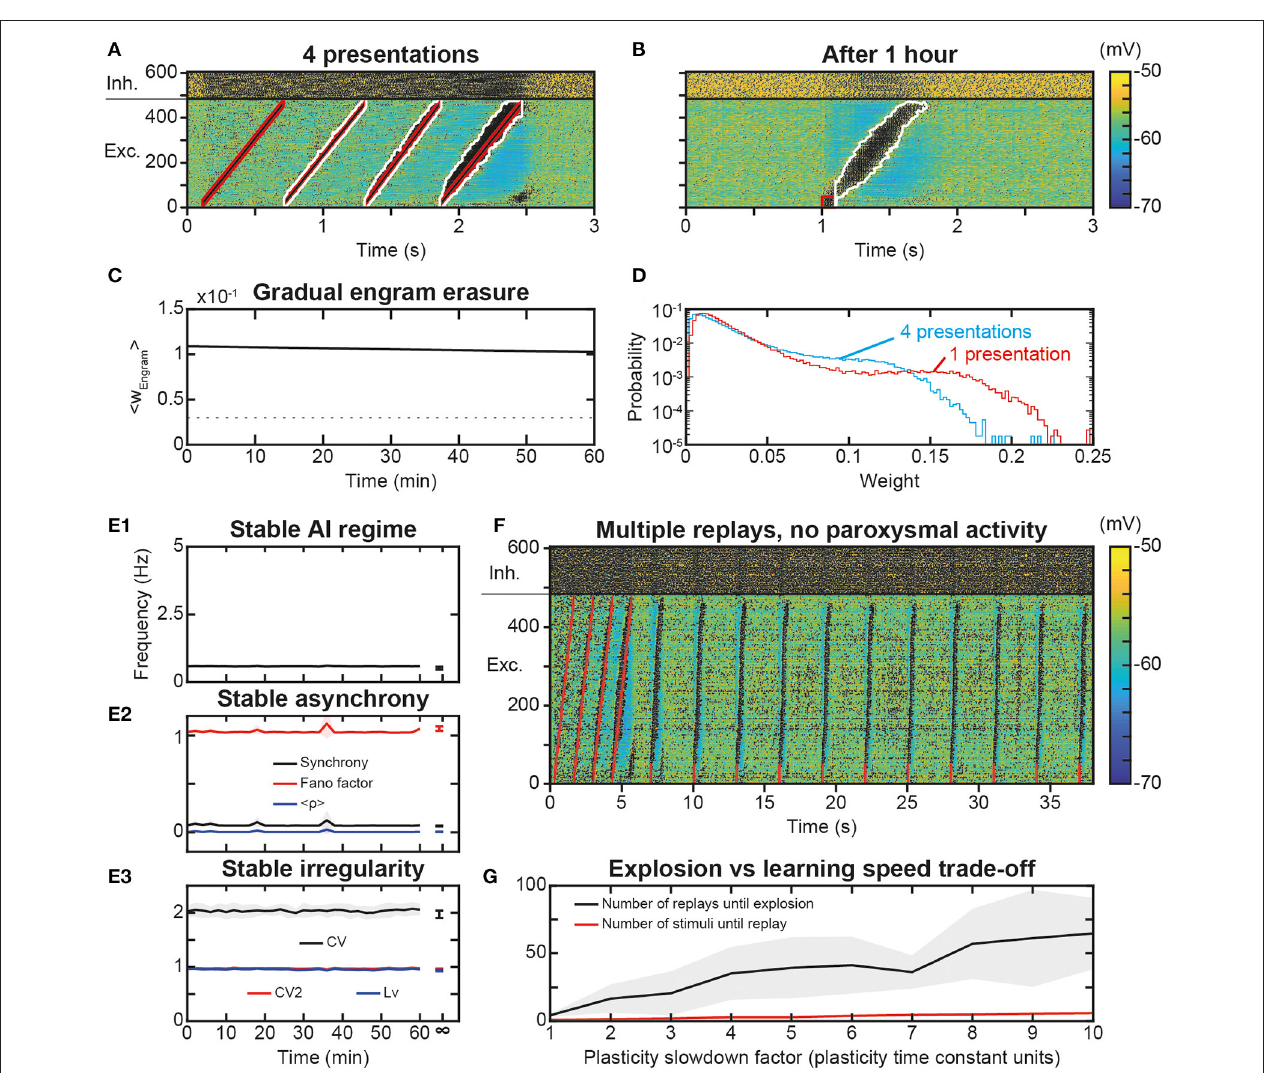
FIGURE 8 | Slower learning stabilization of the engram and network dynamics. (A) . Membrane potential of the neural network in response to the presentation of 4 trajectory stimuli in the presence of slower STDP learning kinetics. (B) . Membrane voltage of the neural network for 3s following a replay stimulation on the first 50 neurons at 1s, 1h after trajectory learning. (C) . Average weight of all engram synapses after learning for 1h. (D) . Probability distribution of the synaptic weights of the excitatory synapses after 4 presentations of the trajectory stimulus during slow learning (blue), and after one presentation of the trajectory stimulus during learning with faster (standard) parameters (red). (E) Networks dynamics after learning with slow plasticity: frequency (E1) , synchrony (E2) , and irregularity (E3) of excitatory neurons. Shaded areas represent 95% confidence intervals of the mean for five network simulations. (F) Membrane potential of the neural network for 38s during which a replay stimulus is performed on 50 neurons every 3s for 10 total repetitions (as in Figure 7A ) after 4 trajectory stimuli in the presence of slower STDP learning kinetics (as in Figure 8A ). (G) Minimal number of stimulus presentations required to learn a replay (red) and maximal number of replays before paroxysmal activity (black), as a function of the plasticity slowdown factor expressed in units of plasticity standard time constant (i.e., by which slowdown factor plasticity rates are divided). The number of replays until explosion is evaluated with the same weight matrix (learned at standard plasticity speed or x1 slowdown) across different plasticity speeds, for better comparison of the effect of plasticity speeds on replay. Shaded areas represent 95% confidence intervals of the mean for 10 network